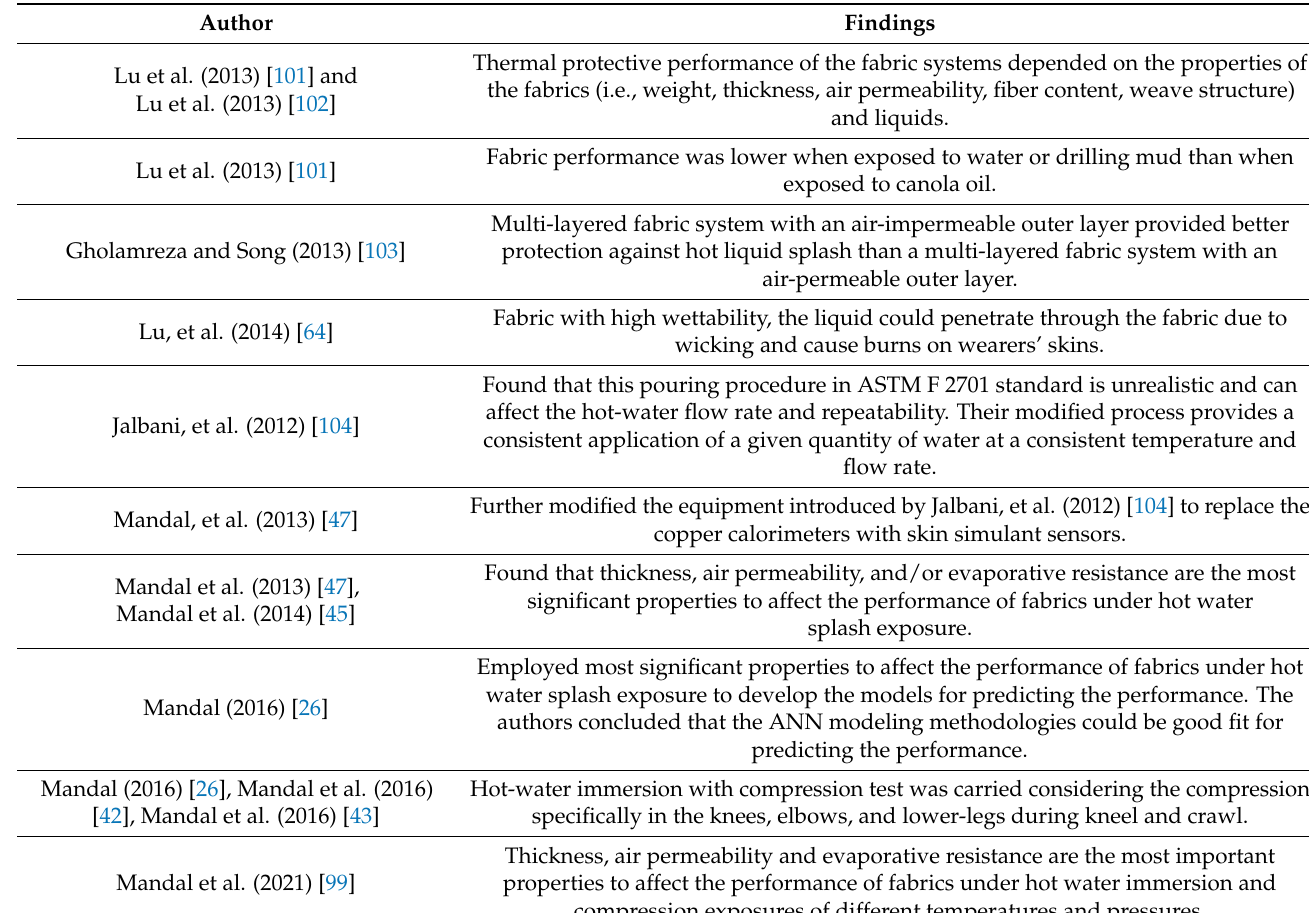
Table 5. Thermal protective performance under hot water